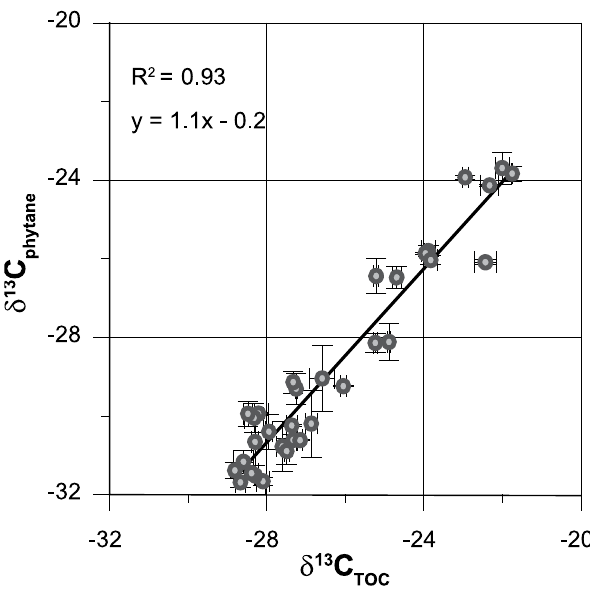
Fig. 3. Sulfur-bound δ 13 C phytane values plotted versus δ 13 C TOC . Error bars are based on replicate analyses. Line indicates lineair regression, with an r 2 of